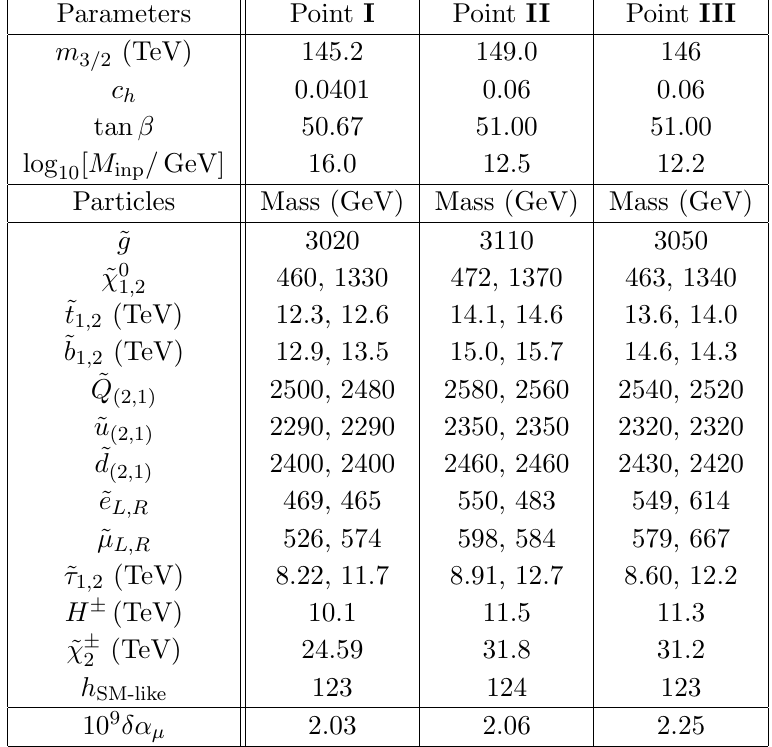
Table 1 . Mass spectra for some model points. On all the points the wino is the LSP. We denote the second and (cid:12)rst generation squarks by ~ X down type squark masses is taken. Here, c h and tan (cid:12) are set at M inp and The Point I is out of the 1 (cid:27) range of the muon g (cid:0) 2 if we adopt the result of ref. [5]. m = 146 TeV are shown. The wino (gluino) mass is around 463 GeV (3060 GeV). In 3 = 2